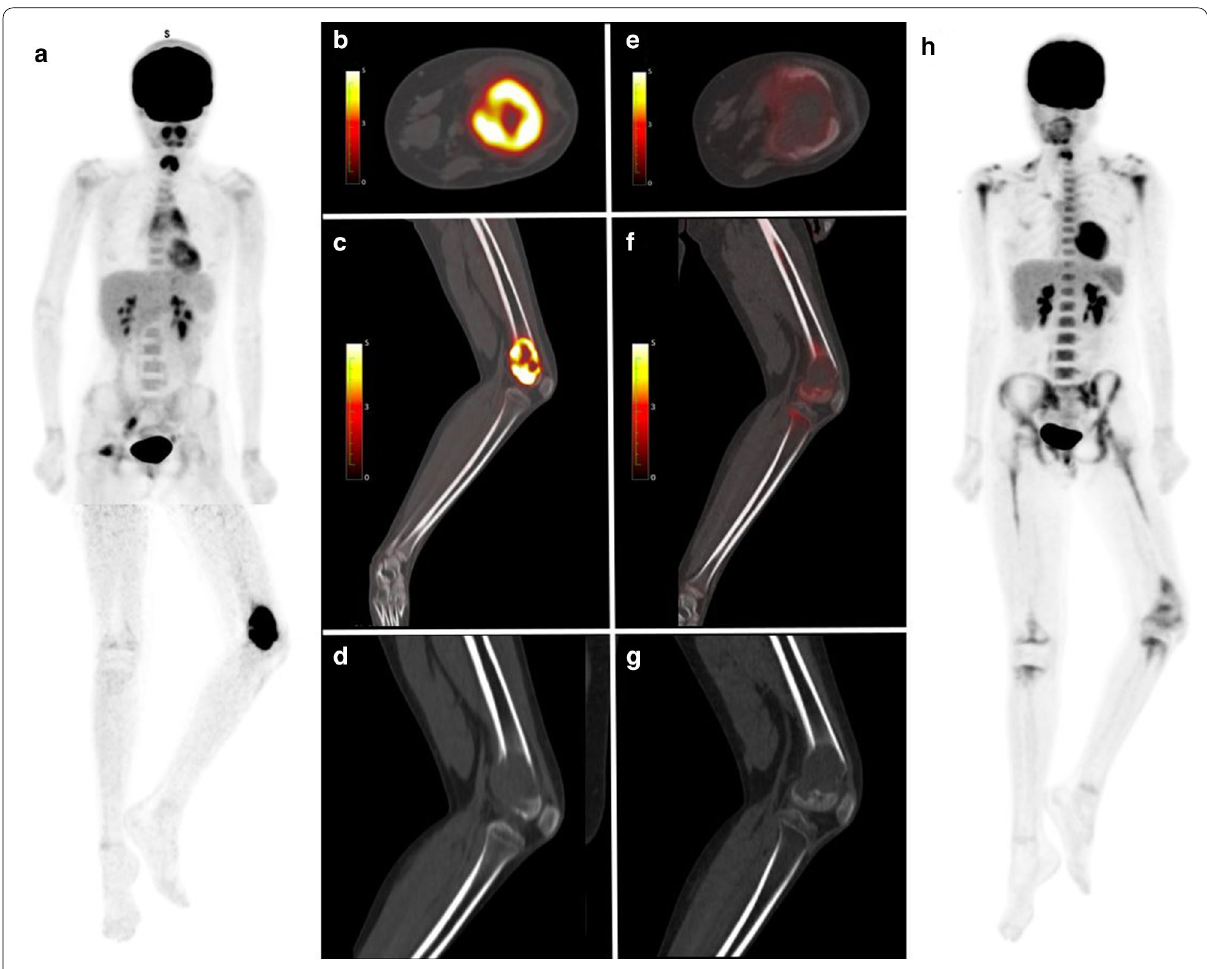
Fig. 4 Eleven‑year‑old girl diagnosed with left distal femur osteosarcoma. PET‑1 ( a – d ) showed stage IIa localized [18F]FDG avid disease (SUVmax 15.2; MTV 113.2 mm 3 ; TLG 84.4). Non sarcoma related [18F]FDG uptake was visualized in the thymus (physiologic), the right adnexa